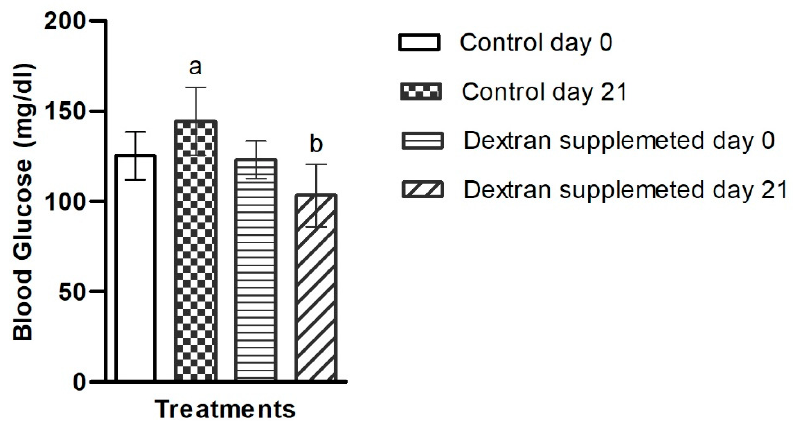
Figure 8. Blood glucose level of Apilactobacillus waqarii EPS in comparison with control at day 0 and 21. The values of data sets ( n = 6) denoted by different alphabet are significantly different ( p < 0.05).